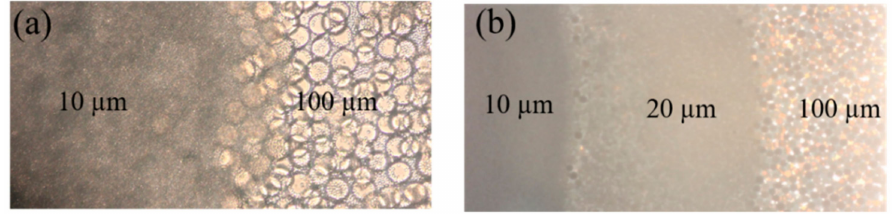
Figure 2. Optical microscopy images of ( a ) the stacking of 100 µ m and 10 µ m microspheres, and ( b ) stacking of microspheres with the size of 100 µ m, 20 µ m and 10 µ